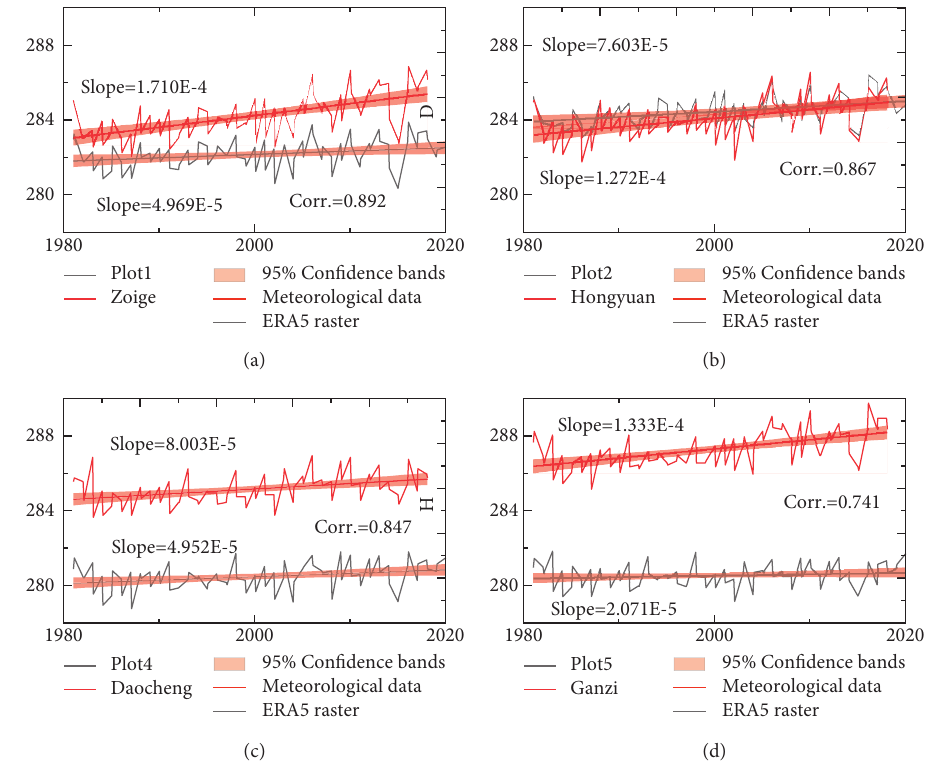
Figure 17: Consistency analysis of meteorological observation data and ERA5 Table 3: Wetland area of swamps and lakes in different periods under the same standard (hm 2 ).